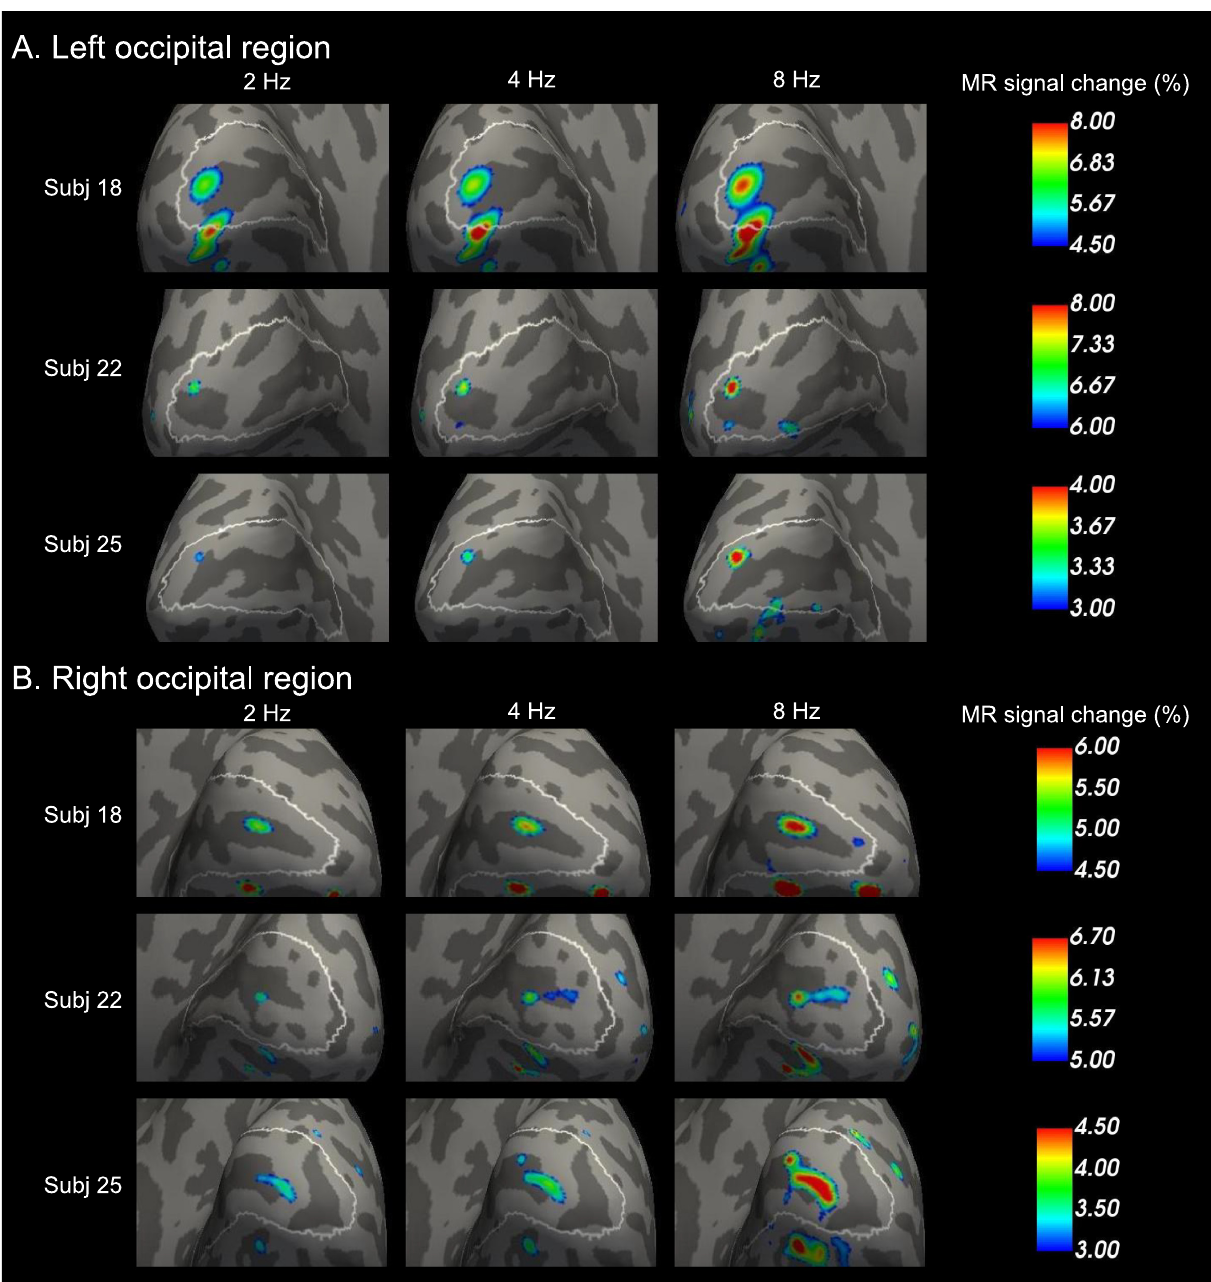
Fig 1. Peak BOLD activities in V1 increase as temporal flicker frequency increases (2, 4, and 8 Hz) in three representative participants. (A) MR signal changes are overlaid on an inflated brain surface of each participant in the left occipital region. The brain surfaces are shown from a posterior/ medial viewpoint. White lines on the brain surfaces indicate the border of V1, based on cytoarchitecture using vcAtlas [35]. Dark and light gray regions represent sulci and gyri, respectively. Calcarine sulci are dark gray regions passing near the center of V1 and extending from anterior to posterior within the region bordered by the white lines (i.e., V1). Peaks of MR signal change within the region bounded by the white lines (i.e., V1) increase from the left (i.e., 2 Hz) to the right (i.e., 8 Hz). (B) Results in the right occipital region correspond to (A).